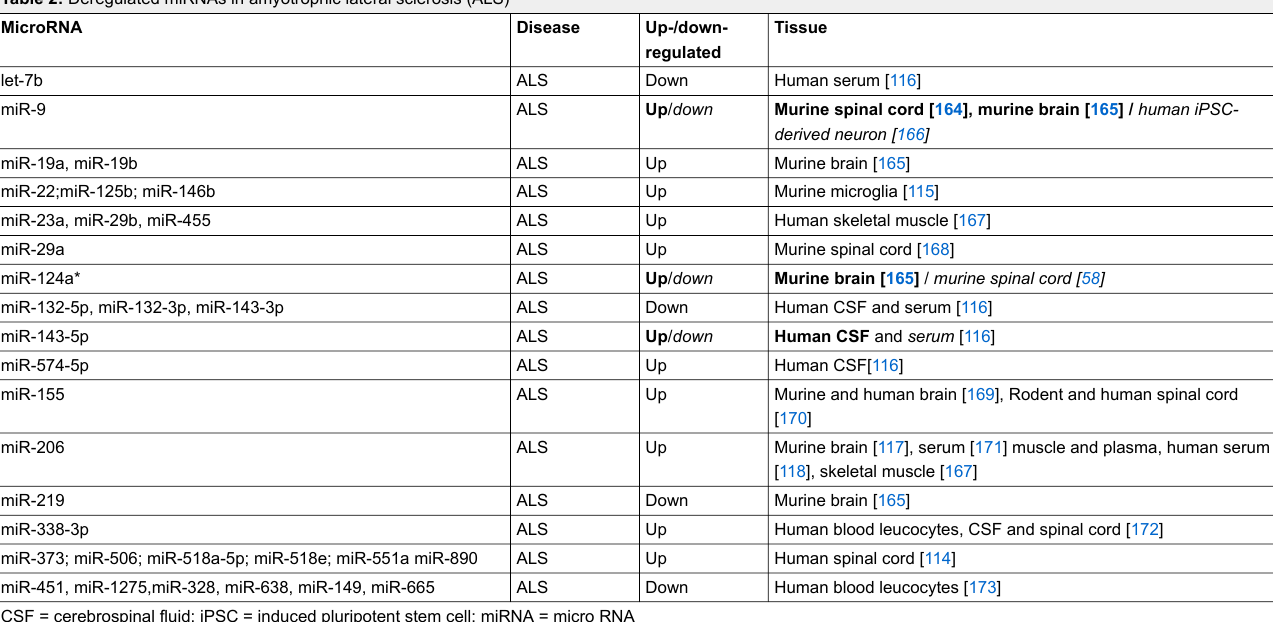
Table 2: Deregulated miRNAs in amyotrophic lateral sclerosis (ALS) MicroRNA Disease Up-/down-